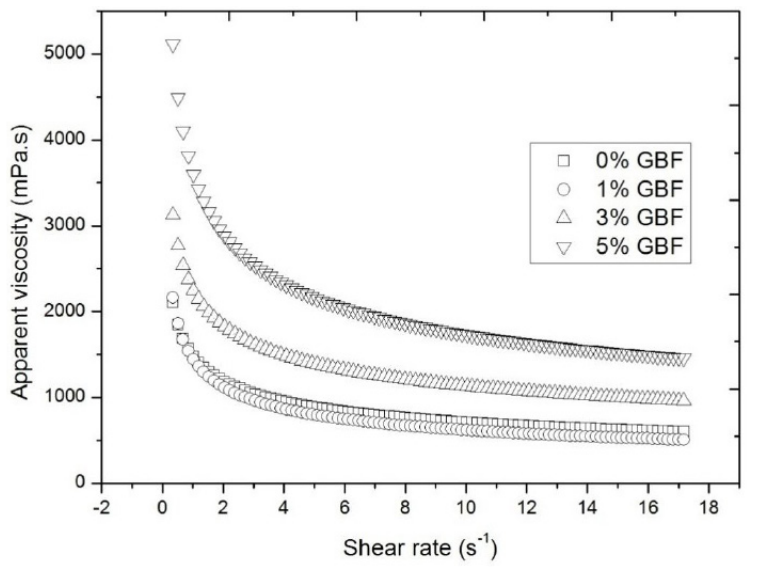
Figure 1. Apparent viscosity ( η ) as a function of shear rate a (viscosity curve) of the different formulations of guava juice containing by-product (GBF) described in the Table III.